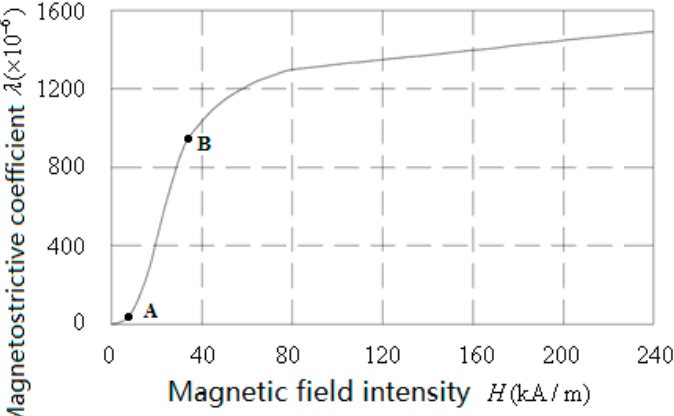
Figure 6. The H − λ curve of the GMM rod.